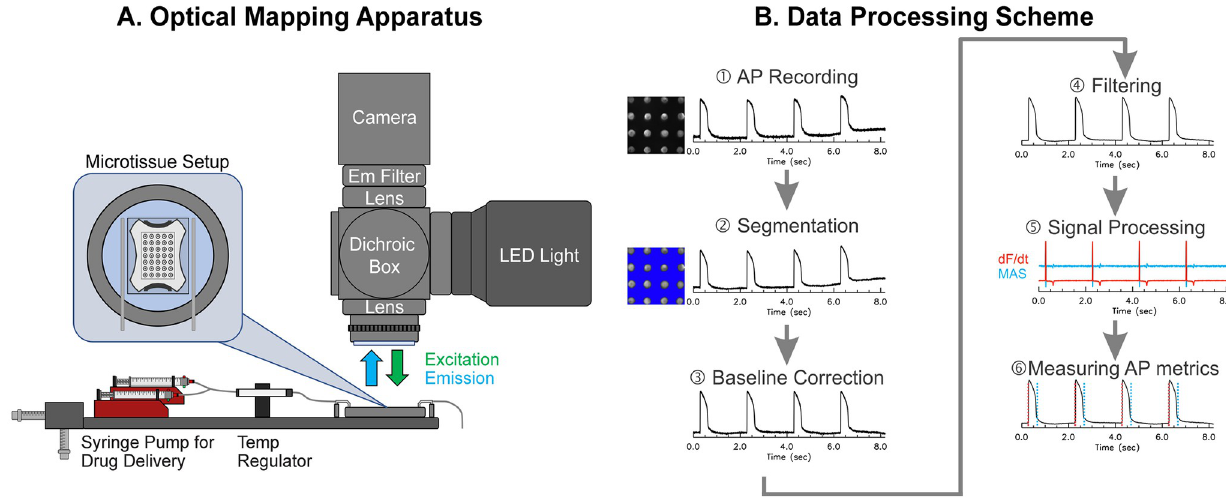
Fig 1. Schematics of fluorescence recording apparatus and data processing. (A) Optical apparatus to record action potential (AP) from hiPSC-derived cardiac microtissues. (B) Schematic of the data processing pipeline. A series of data processing steps were taken to measure AP metrics: ① AP recording. ② segmentation for identification of individual microtissues, ③ baseline correction to remove fluorescence changes due to dye bleaching or fluctuation of perfusion solution, ④ filtering to increase signal-to-noise ratio while preserving sharpness of AP upstroke, ⑤ calculation of first derivative and moving average subtraction to detect AP upstroke and repolarization, and ⑥ AP metric